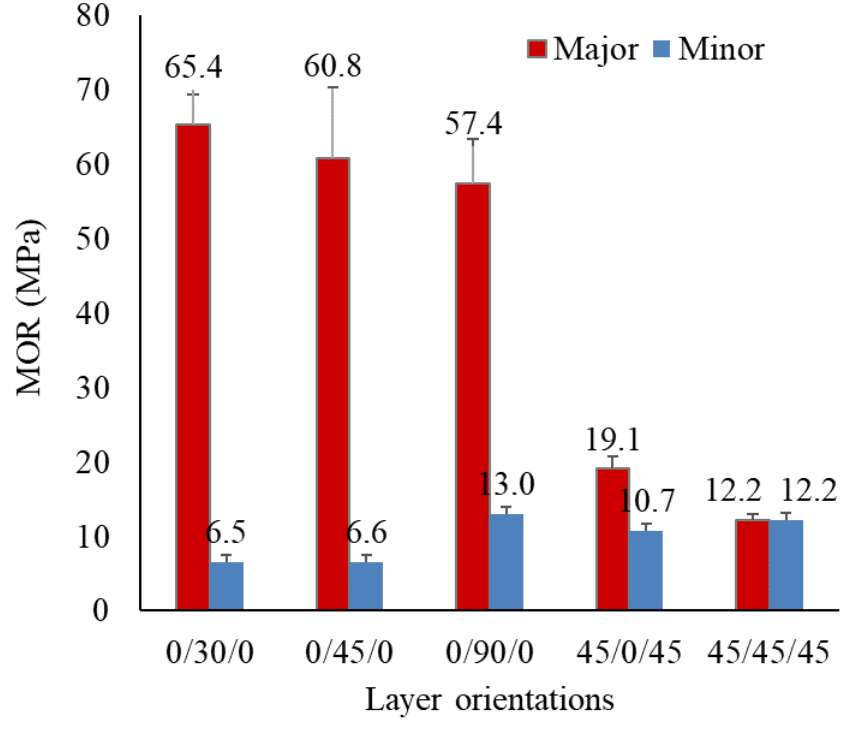
Figure 4. Modulus of rupture (MOR) of CLTs in both major and minor axes.